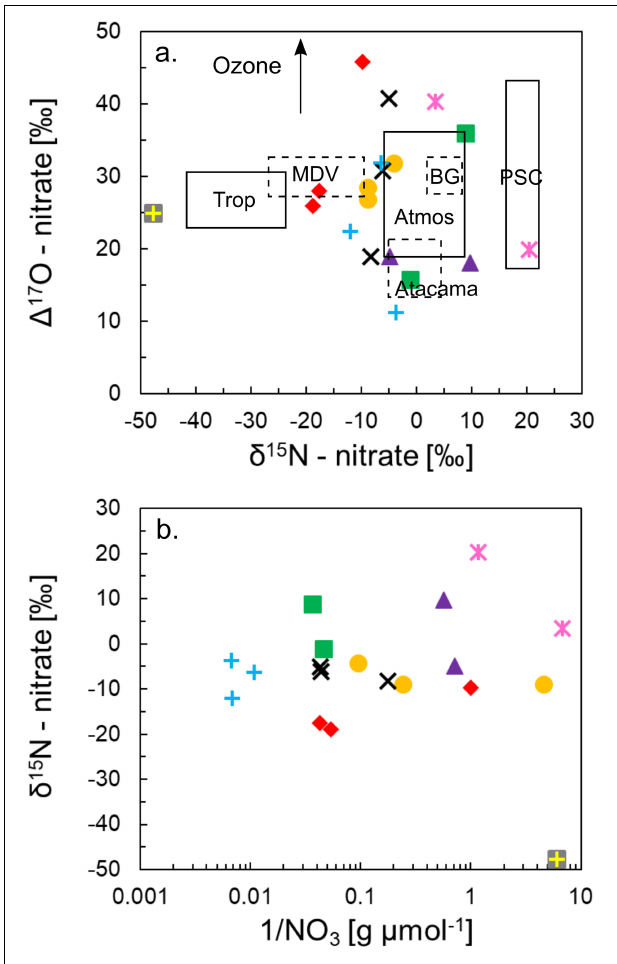
FIGURE 6 | Isotopic composition of NO 3 - for Shackleton Glacier soils (a) and the variation of δ 15 N with inverse nitrate concentrations (b) . The shapes and colors representing the different sampling locations correlate with the key in Figure 2 . The solid black boxes represent the isotopic composition of NO 3 - from the mixed atmosphere, stratosphere [polar stratospheric clouds (PSC)], and troposphere (re-emission from snowpack) (Moore, 1977; Michalski et al., 2003; Savarino et al., 2007). The dashed boxes represent the Beardmore Glacier region (BG), McMurdo Dry Valleys (MDV), and Atacama Desert for comparison (Michalski et al., 2004, 2005; Jackson et al., 2015, 2016; Lyons et al., 2016). The black arrow indicates a potential NO 3 - formation pathway with higher (cid:49) 17 O values from